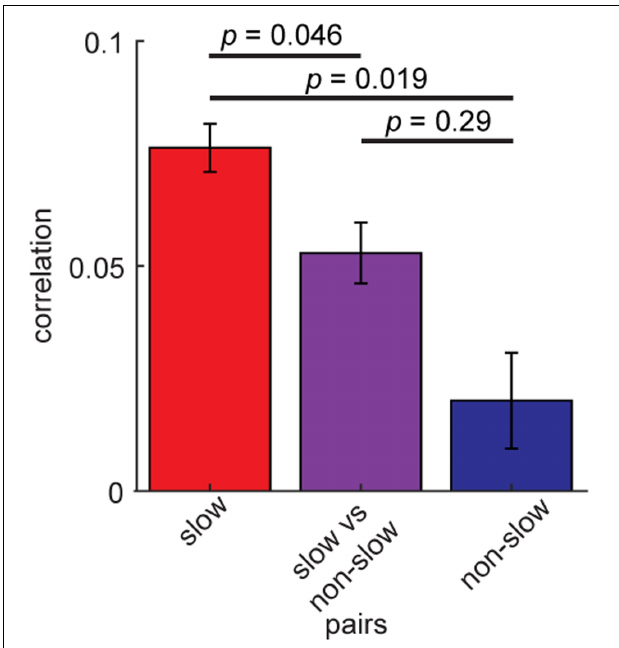
FIGURE 7 | Higher spike count correlations of slow rhythmic BF cells. Mean spike count correlations of slow ( ≤ 6 Hz) rhythmic BF cells ( n = 140) and other rhythmic BF cells ( n = 23). The effect of pair type was significant ( F 2 , 801 = 5.74, p = 0.0033, one-way ANOVA). P -values of post hoc HSD test are shown. Errors indicate